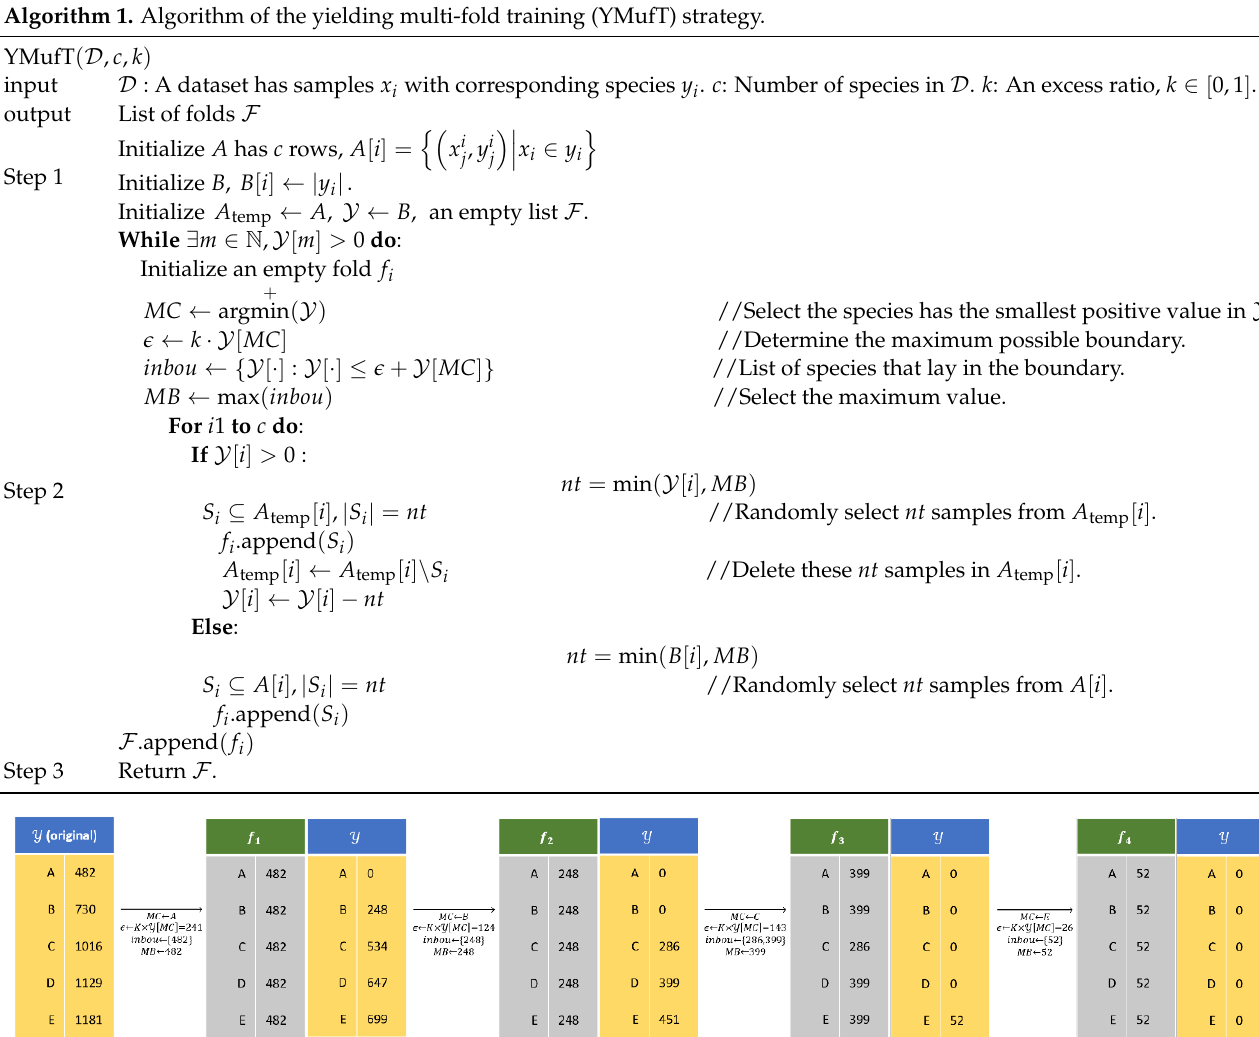
Algorithm 1. Algorithm of the yielding multi-fold training (YMufT) strategy.